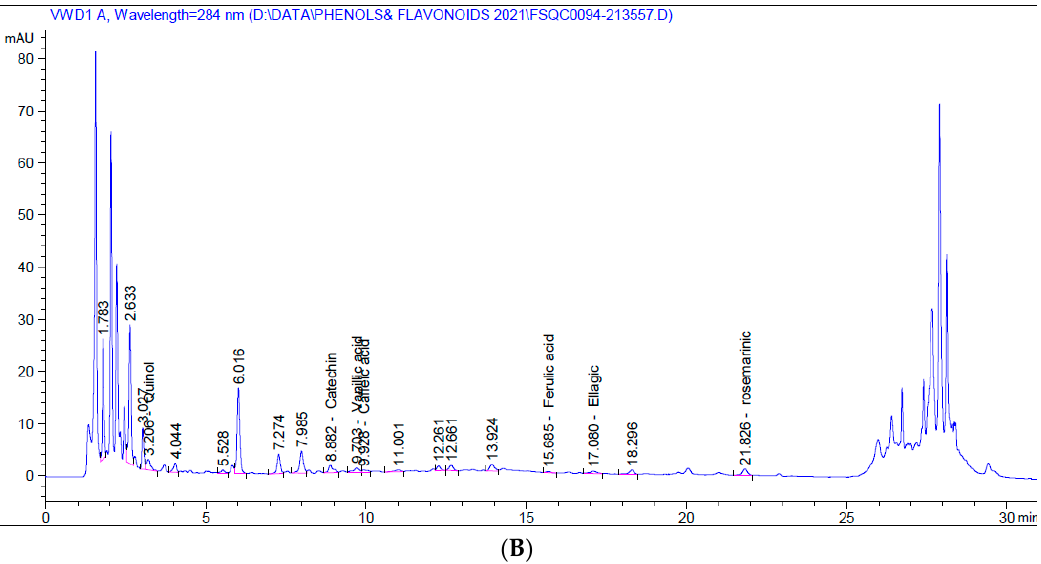
Figure 1. HPLC chromatograms of 5% aqueous ( A ) and alcoholic ( B ) larval extracts.